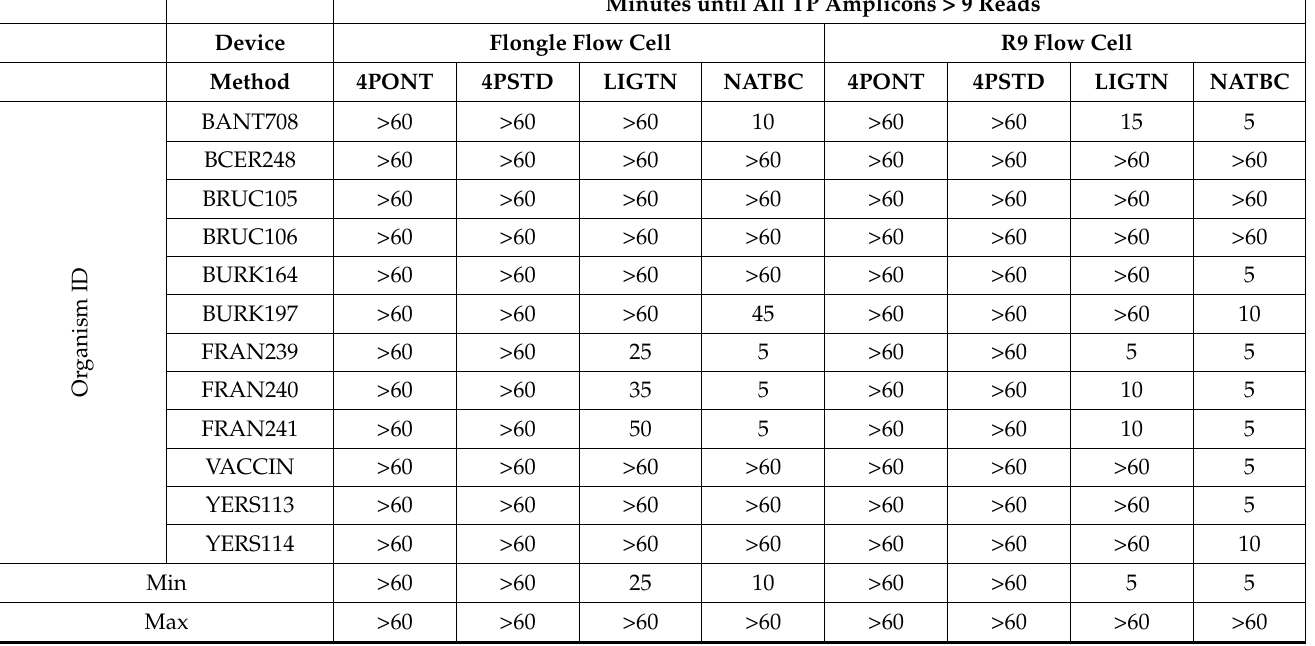
Table 3. Minimum sequencing time required for TP calls. Minimum sequencing time required for TP calls for ( A ) FL type flow cell and ( B ) R9 type flow cell. TP was defined as >9 reads aligning to the associated amplicon reference in all three replicates per